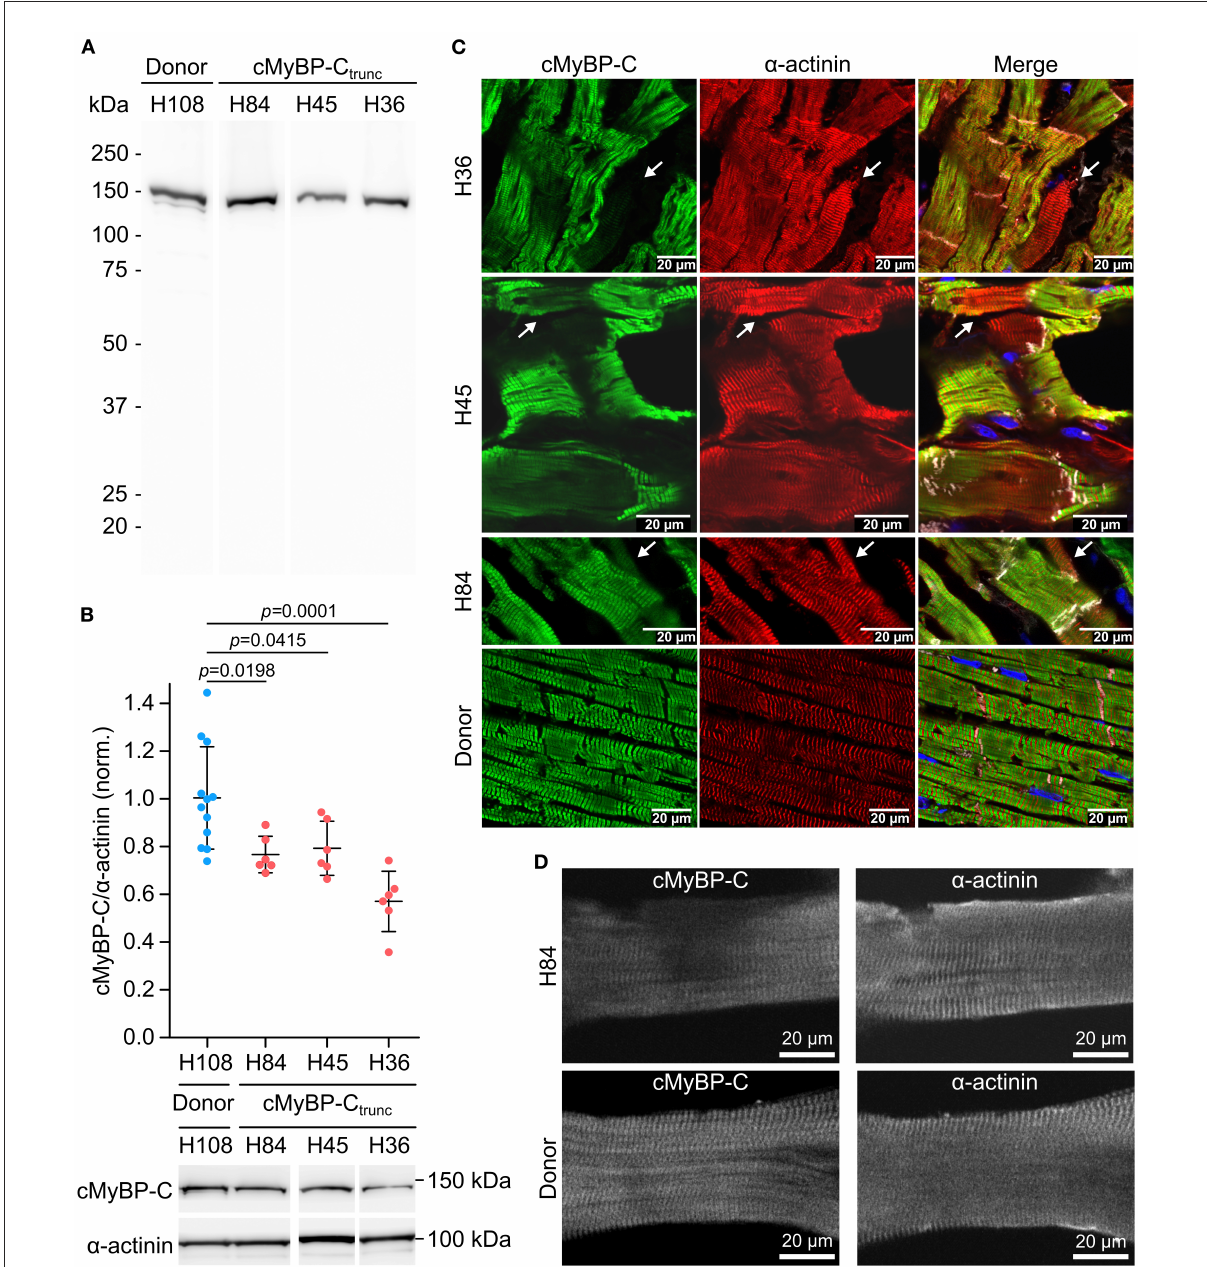
FIGURE3 Unequal expression of cMyBP-C in cardiomyocytes of the cMyBP-C trunc patient. (A) Western blot of one donor sample and three cMyBP-C trunc patients H84 ( MYBPC3 c.927 − 2A > G ), H45 ( MYBPC3 c.1458 − 6G > A ) and H36 ( MYBPC3 c.2864_2865delCT ) was incubated with an N-terminal cMyBP-C antibody. Detection of full-length WT-cMyBP-C ( ∼ 140 kDa) and possible truncated cMyBP-C was performed with 5s exposure time. (B) Relative protein amount of cMyBP-C was calculated from IOD of the cMyBP-C band divided by IOD of α -actinin for normalization. IOD of α -actinin band at 103 kDa was quantified as loading control. IOD ratio (cMyBP-C/ α -actinin) from one donor sample (blue dots, n = 12 lanes) and compared to data from cMyBP-C trunc patients (red dots, n = 6 lanes each). For comparison of patient results (H84, H45, H36) with donor (H108) reference one-way analysis of variance (ANOVA) and Dunnett’s post-hoc test were performed. ANOVA yielded significant variation among groups [F(3, 26) = 10.17, p = 0.00013]. Mean ± SD and p-values from Dunnett’s test are indicated in the figure. (C) Cryosections (5 or 10 µ m) from cMyBP-C trunc patients and donor myocardium were stained with an N-terminus-specific antibody for cMyBP-C (left panels, green) to visualize cell-to-cell cMyBP-C distribution. Co-staining with an α -actinin antibody (middle panels, red) reveals sarcomeric Z-lines. Right panels, merge with N-cadherin (white) and DAPI (blue) staining. Images were either taken by confocal laser scanning microscopy (H36, MYBPC3 c.2864_2865delCT and H45, MYBPC3 c.1458 − 6G > A ) or by epifluorescent microscopy (H84, MYBPC3 c.927 − 2A > G ). White arrows indicate cells with substantially reduced cMyBP-C signals. (D) Confocal microscopy of single cardiomyocytes from cMyBP-C trunc (c.927-2A > G, H84) patient or donor co-stained for cMyBP-C and α